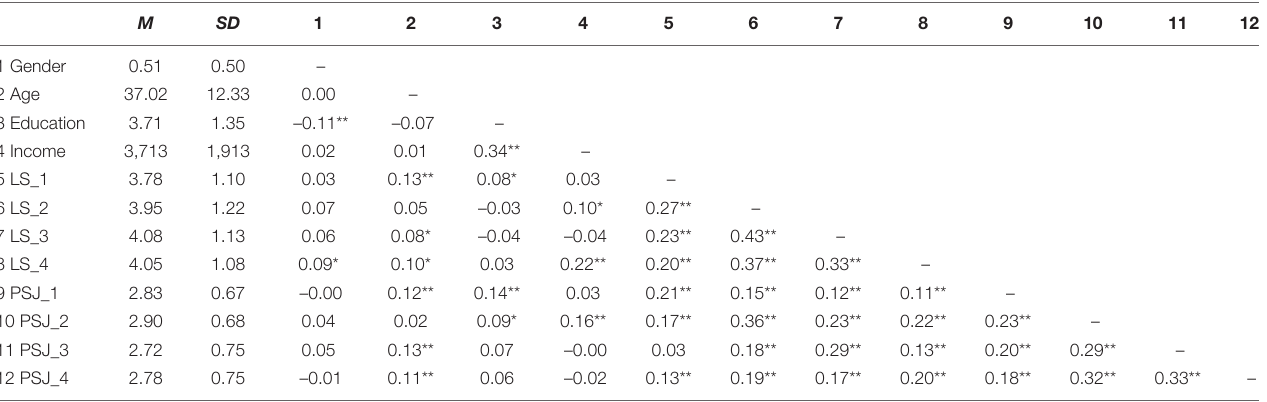
TABLE 3 | Means, standard deviations, and correlations in study 2.